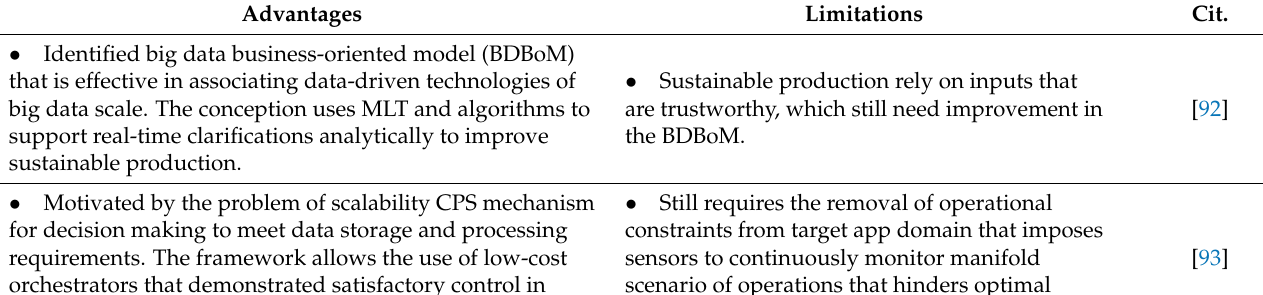
Table 5. An inductive analysis of IoT as a CPS to deliver big